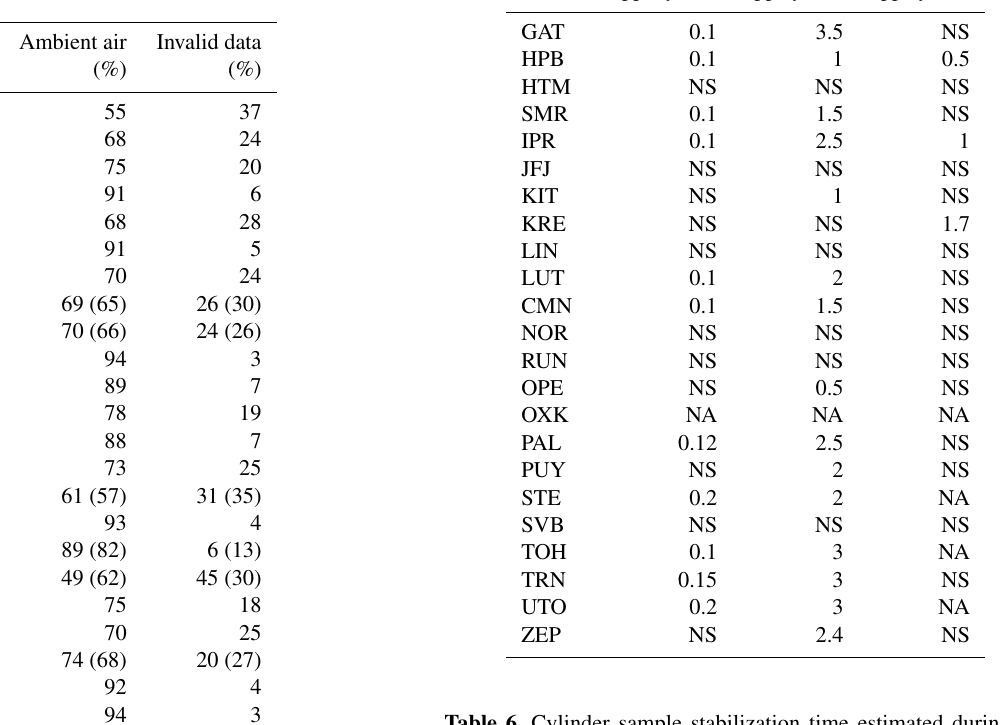
Table 4. Percentage of ambient air and invalid data (manual and automatic, including flushing for air and cylinders) over the whole dataset at each station, aggregating instruments if more than one was used, over the period March 2019–March 2020 or over the available period within these dates if shorter (for stations labeled in November 2019 notably). CO percentages are indicated between brackets when different, i.e., when measured with another analyzer than CO 2 and CH 4 and installed later.